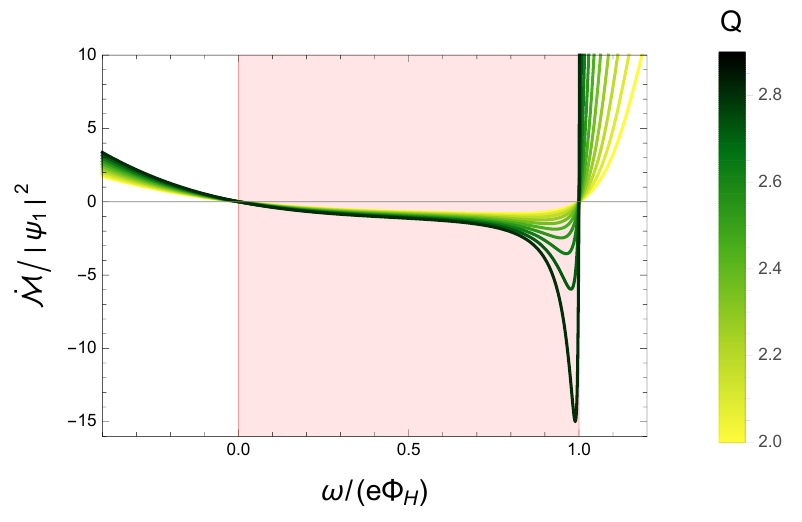
Figure 2 . The ω/ ( e Φ H ) dependence of the energy variation ˙ M / | ψ 1 | 2 for the black hole charges Q = 2 . 0 , 2 . 1 , · · · , 2 . 9 . The superradiant condition is satisfied in the red